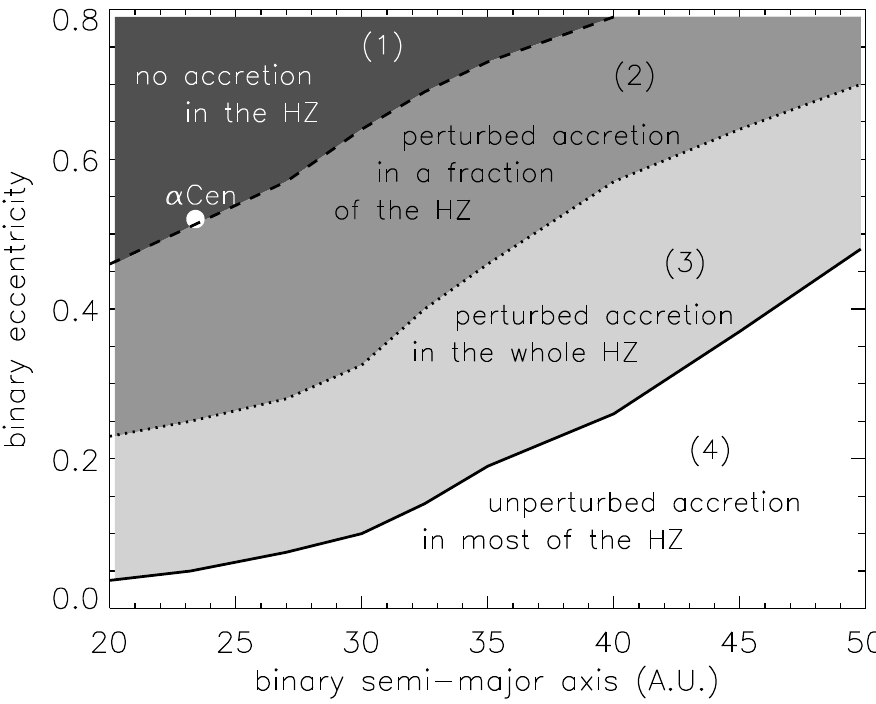
Figure 7. Accretion vs. Erosion behavior of a population of kilometer-sized planetesimals in the habitable zone around α Centauri B when varying the binary’s separation and eccentricity. The white circle marks the current orbit of the binary. This shows that planetesimal accretion is possible if the binary has suffered a stellar encounter that shrank its initial wider orbit to its current value (taken from [36], courtesy of the